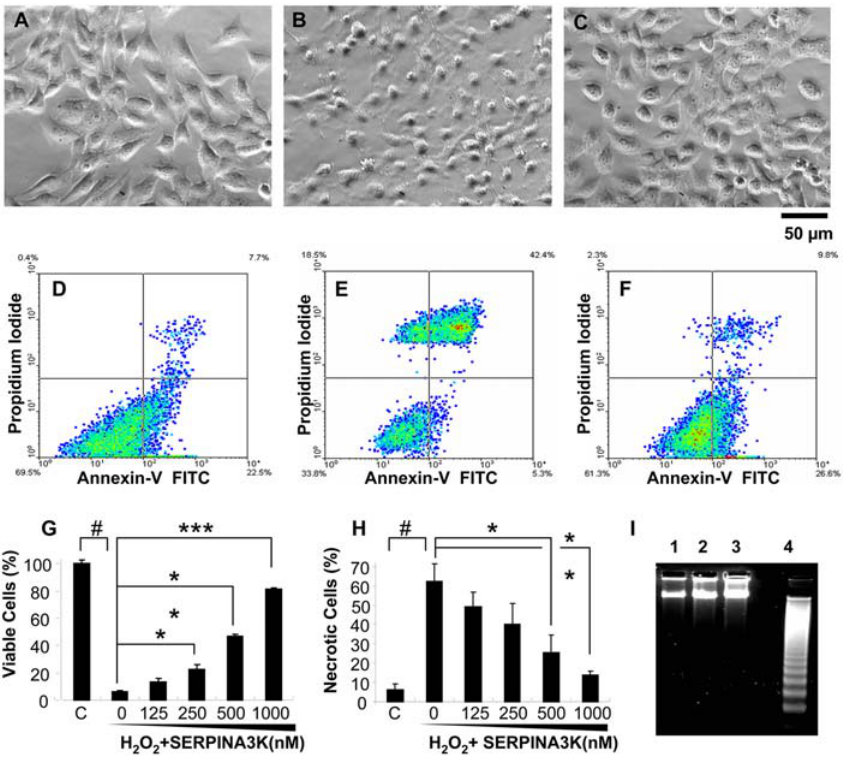
Figure 2. Protective effects of SERPINA3K on rMC-1 cells against H 2 O 2 -induced necrosis. Mu¨ller-derived rMC-1 cells were pre-treated with SERPINA3K or BSA for 1 h and then exposed to 400 m M H 2 O 2 for 8 h ( A–C, G ) and 4 h (D–F, H, I). The protein concentration in the media was brought to 1 m M in each well by addition of BSA. ( A–C ) Representative phase contrast images showing cell morphology in untreated control ( A ), cells treated with 1 m M BSA and H 2 O 2 ( B ), and cells treated with 1 m M SERPINA3K and H 2 O 2 ( C ). Scale bar, 50 m m. ( G ) Viable cells were quantified using the MTT assay (mean 6 SEM, n=3). ( D–F, H ) The viable and necrotic cells were analyzed by flow cytometry following staining with PI and Annexin-V; ( D ) Untreated control; ( E ) treated with 1 m M BSA and H 2 O 2 ; ( F ) treated with 1 m M SERPINA3K and H 2 O 2 ; ( H ) quantification of necrotic cells as percentages of total cells (mean 6 SEM, n=3). ( I ) DNA laddering analysis showed no apparent DNA fragmentation in the H 2 O 2 -treated cells. Lane 1, control cells; 2, cells treated with H 2 O 2 for 4 h; 3, cells treated with H 2 O 2 and SERPINA3K, and 4, over-grown cells as positive control. # P , 0.001, H 2 O 2 treated cells versus control cells. * P , 0.05, ** P , 0.01, *** P , 0.001, the cells treated by different doses of SERPINA3K versus the cells treated only by BSA.